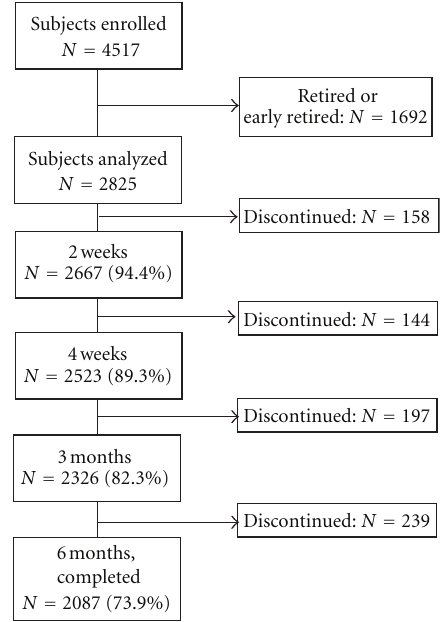
Figure 1: Patient